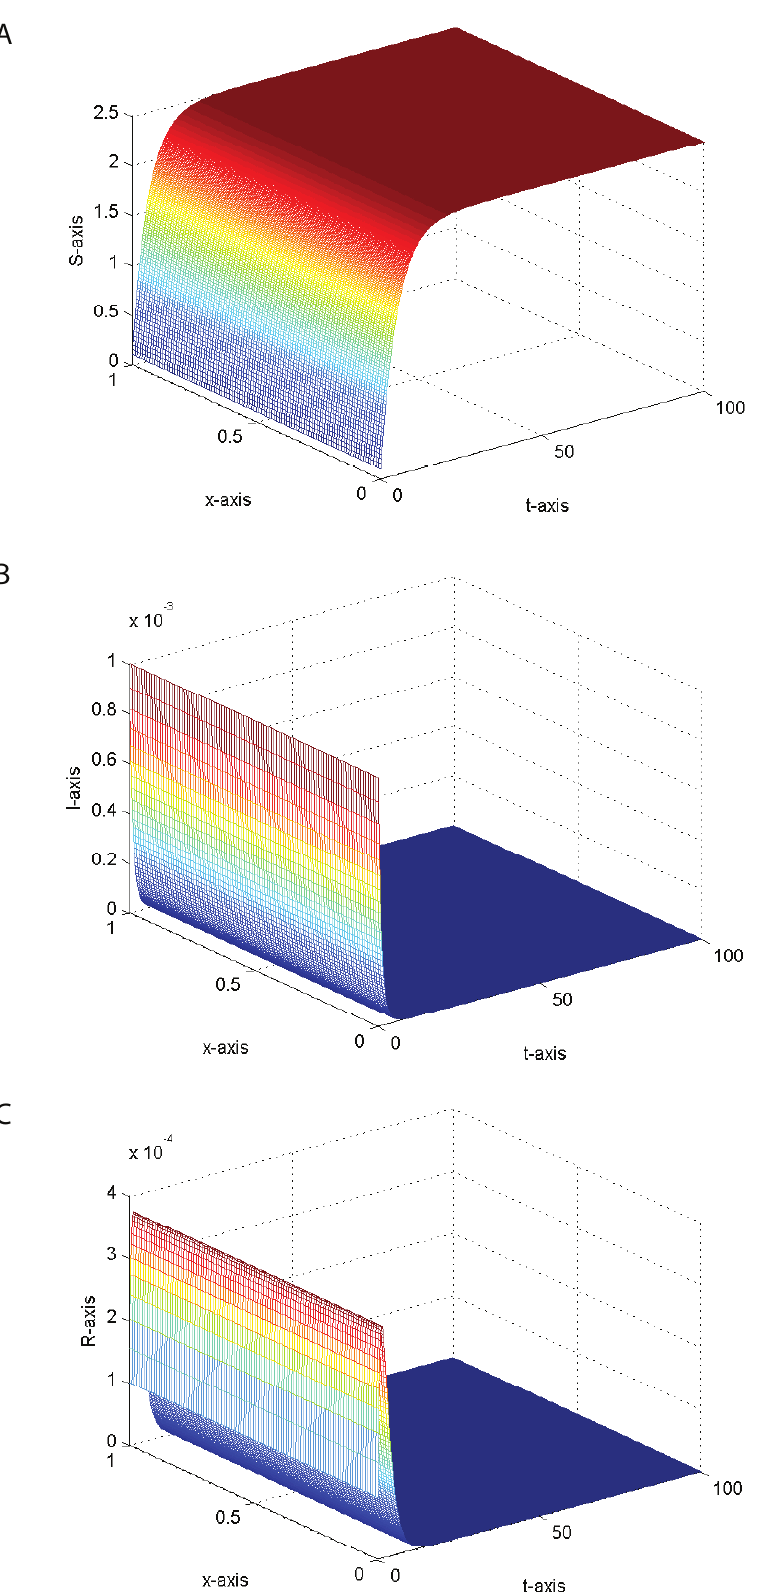
Figure 1. The temporal solution found by numerical integration of problem (0.3) under conditions (0.4) and (0.15) with B ~ 0 : 5 , b ~ 0 : 2 , ª ~ 0 : 6 , a ~ 0 : 1 , m 1 ~ 0 : 2 , m 2 ~ 0 : 4 , m 3 ~ 0 : 5 , D ~ 10 , t ~ 0 : 2 and d 1 ( x , t ) ~ 0 : 1 , d 2 ( x , t ) ~ 0 : 001 , d 3 ( x , t ) ~ 0 : 0001 , t [ ½ ” 0 : 2 , 0 (cid:2) .